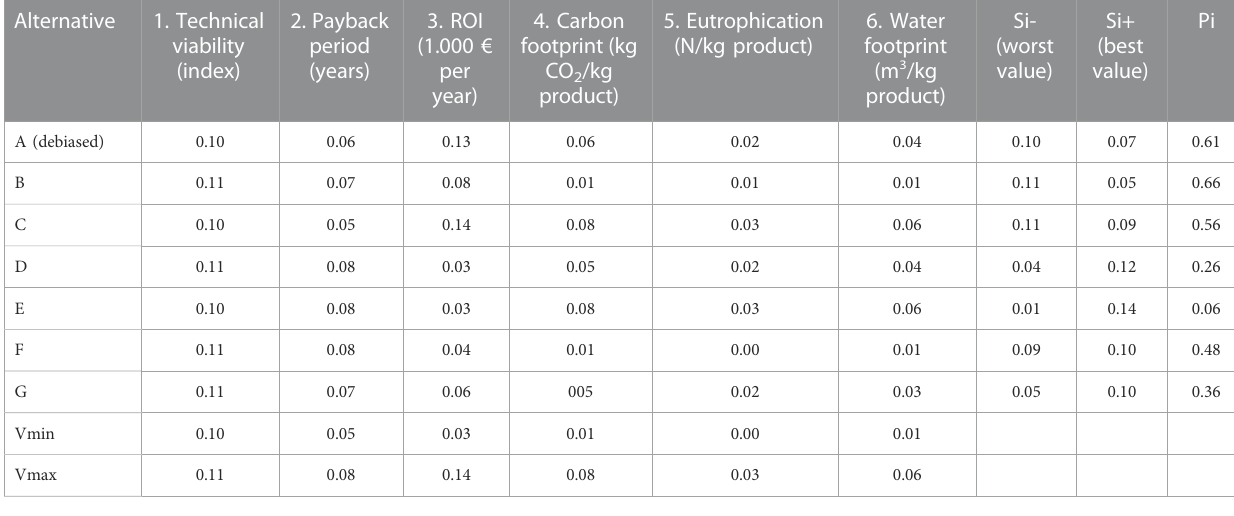
TABLE 6 Weighted normalized decision matrix for Company A with calculated performance score (Pi) of each alternative (A – G) based on their S i − and S i + values.